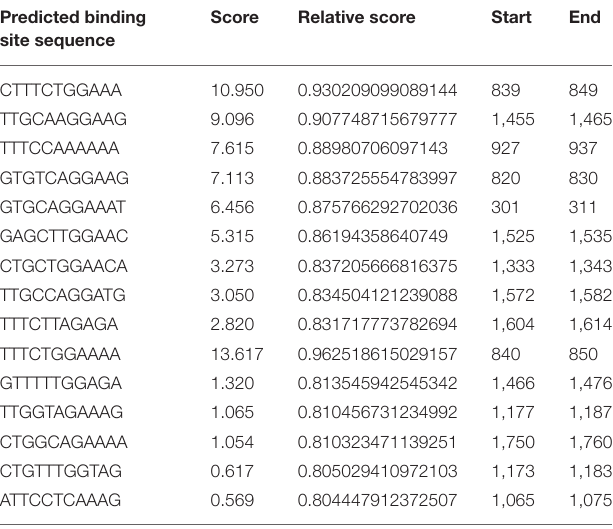
TABLE 4 | STAT3 binding sites at the promoter region of IL6 as predicted using